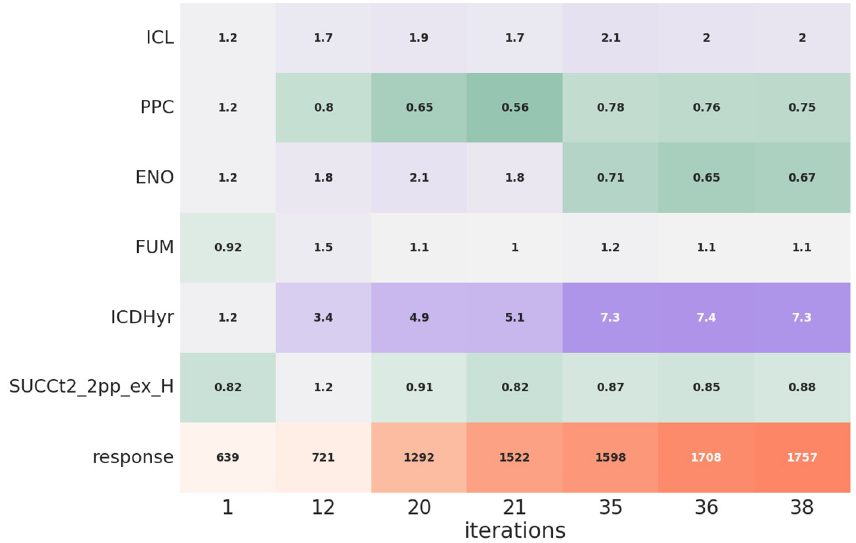
Fig 2. Illustration of strain design optimization using the MARL approach for succinic acid . The first 6 rows correspond to the enzyme levels and in the last row the response (product exchange flux � growth) is presented. Each column represents the enzyme levels design and the corresponding response which has been found in the iteration mentioned at the